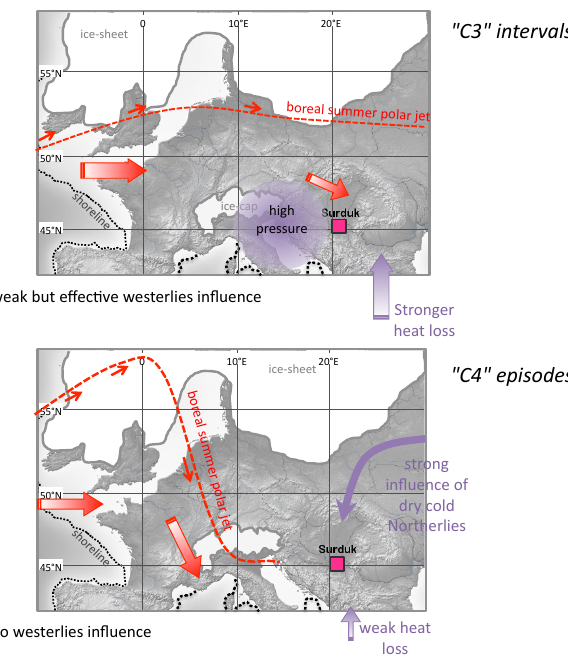
Fig. 5. Atmospheric pattern explaining C 3 and C 4 episodes. Up- per panel: atmospheric pattern effective during C 3 episodes; Sur- duk is under a weak but effective influence of westerlies, allowing the more than 2–3 months of available water required for the C 3 growth cycle. Lower panel: atmospheric pattern that prevailed dur- ing the C 4 episodes; Surduk is under the strong influence of dry and cold northerlies, leading to less than 3 months of available water. Red arrows are from K¨uhlemann et al. (2009) and violet arrows are from Krichak and Alpert (2005) and Josey et al.